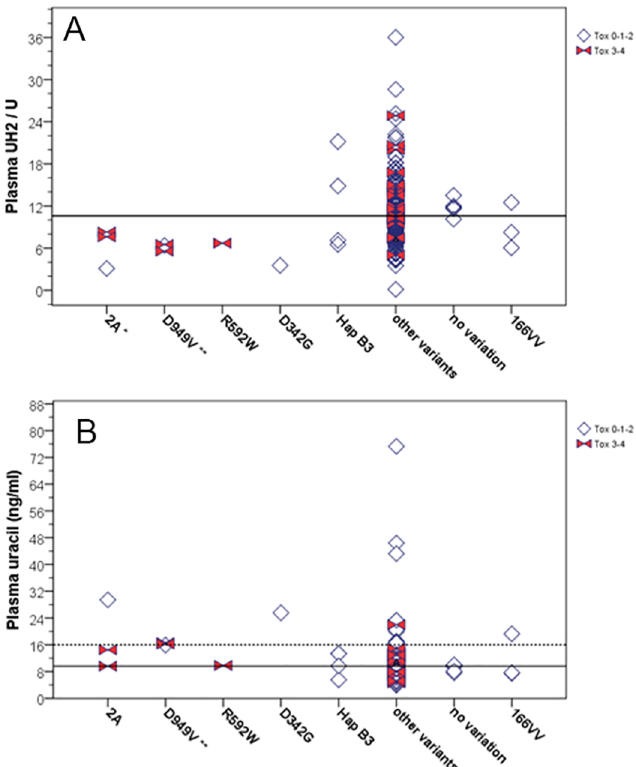
Fig 3. Distributionof pre-treatment plasma UH2/U ratio (A) and Uracil concentrations (B) for the 205 patients with validatedphenotypic data, accordingto DPYD variants of interest: variant * 2A (3 heterozygous patients), D949V(3 heterozygous patients), R592W (1 heterozygous patient), D342G (1 heterozygous patient), HapB3 (4 heterozygous patients), 166VV (3 homozygouspatients) vs any other variations (185 patients) vs no variation (5 patients). DPD deficiencyis reflected by plasma UH2/U decreaseor plasma uracil increase.All indicatedgenotypes were mutually exclusive. Horizontalsolid lines indicatemedianvalues (10.6 for UH2/U and 9.6 ng/ml for Uracil concentration). Horizontaldotted line on Uracil plot indicatesthe 91st percentile(16 ng/ml) associatedwith enhancedgrade 3–4 toxicity. Open diamondsindicate patients with toxicity grade 0-1- 2 and solid bow ties indicate patients with grade 3–4 toxicity. For variants carried by at least 3 patients, distribution of phenotype was compared betweencarriers and non-carriers using the non-parametric Mann- Whitney test ( * indicates0.01 (cid:20) p < 0.05and ** indicatesp < 0.01).